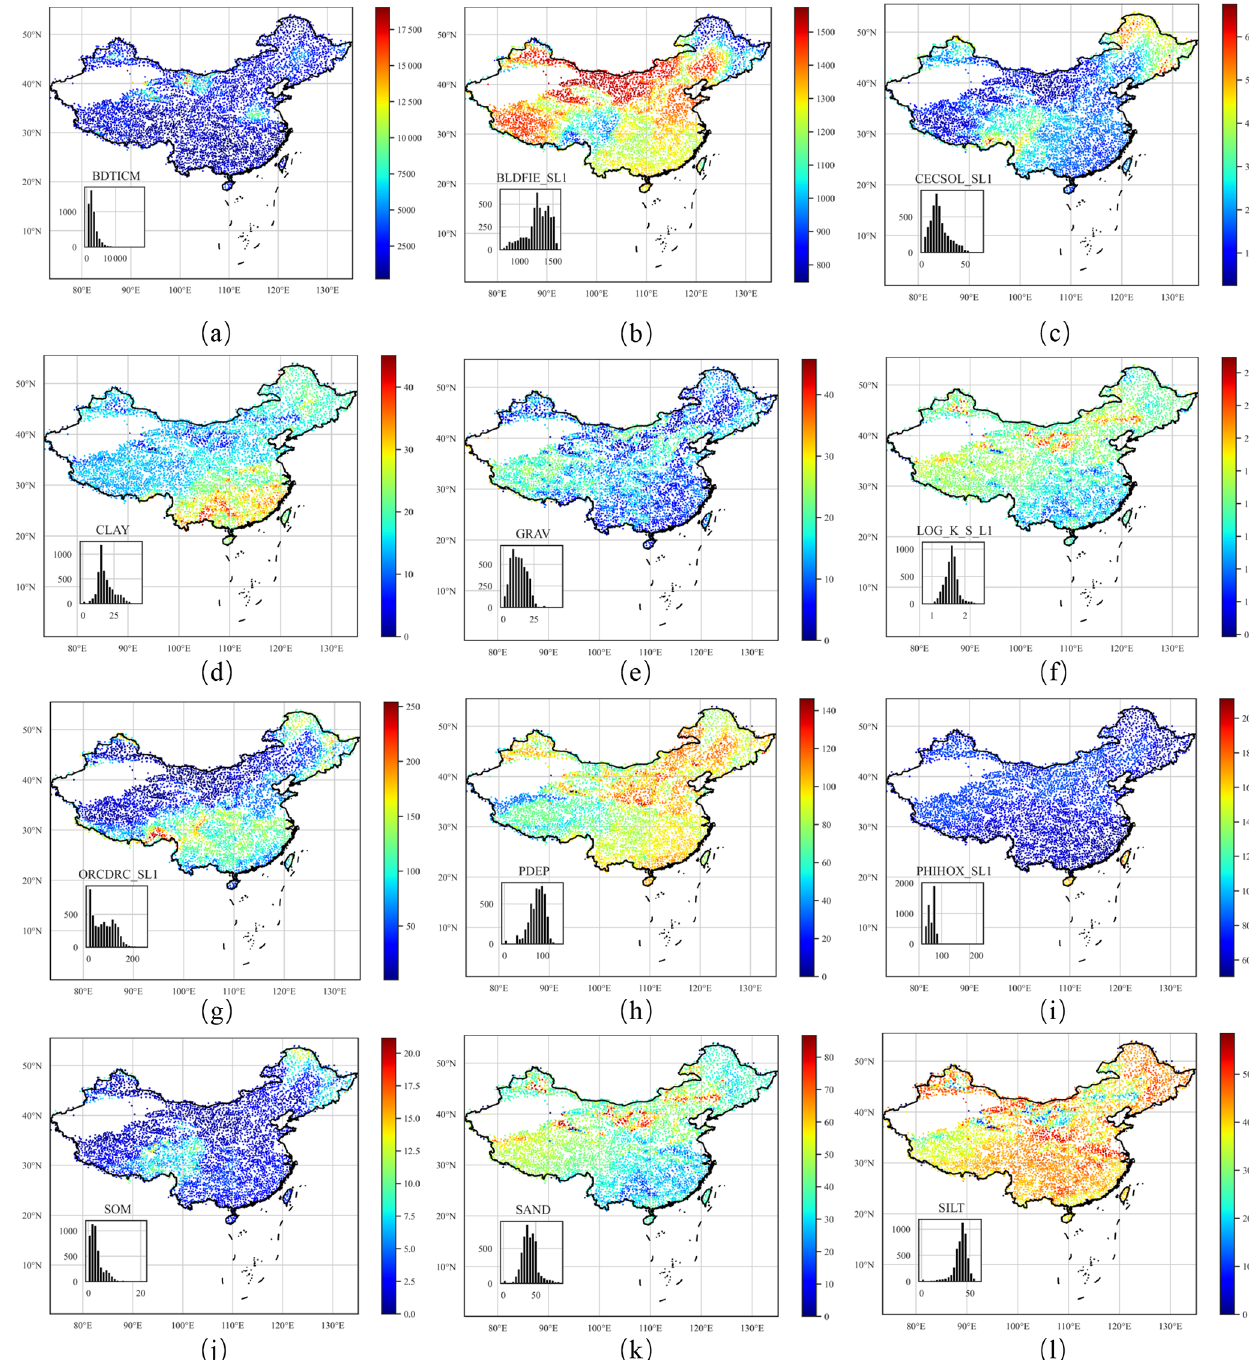
Figure 7. Distributions of soil characteristics throughout